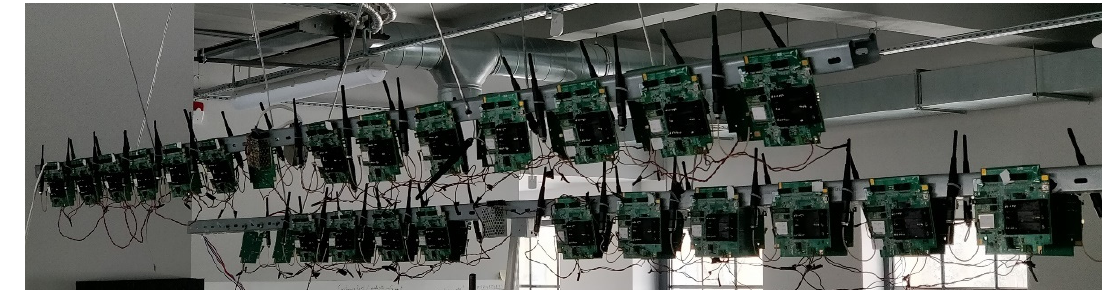
Figure 7. The ISA100.11a certified hardware devices employed in the experimental setup at CDS premises (Cluj-Napoca, Romania)—two out of three test batches. The VR950 and VS210 employ the VN210 radio module as the IEEE802.15.4